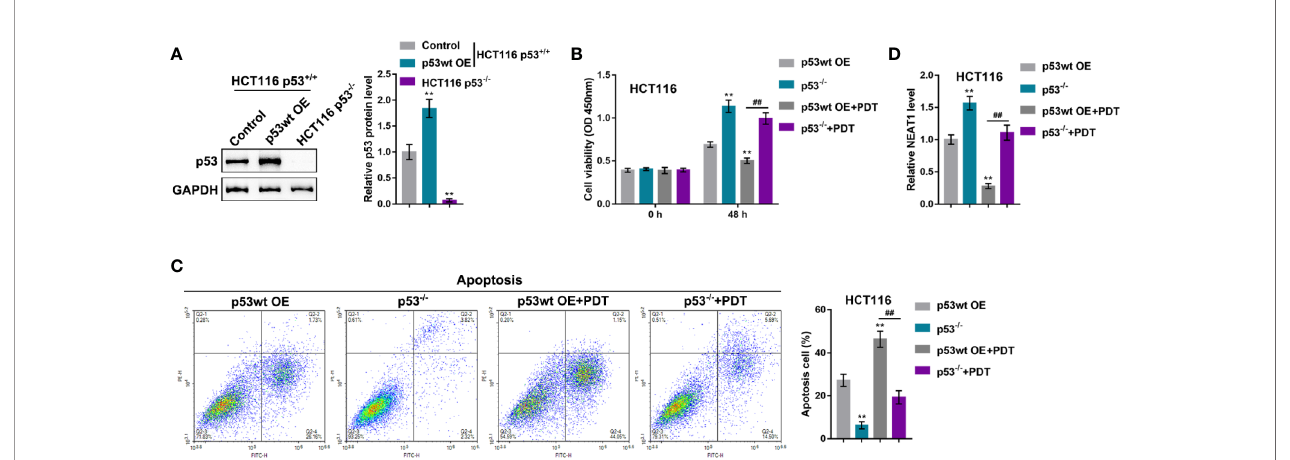
FIGURE 6 | p53 deletion enhances the resistance of CRC cells to PDT. (A) p53 overexpression was achieved in HCT116 cells by the transfecting p53- overexpressing vector (p53 OE). The protein levels of p53 were determined in regular HCT116 cells, p53 OE-transfected HCT116 cells, and p53 − / − HCT116 cells by Immunoblotting. Next, p53 OE-transfected HCT116 or p53-deleted p53 − / − HCT116 cells were treated or non-treated with PDT and examined for cell viability by CCK-8 assay (B) , cell apoptosis by fl ow cytometry (C) , and the expression levels of NEAT1 by qRT-PCR (D) . ** P < 0.01, compared to p53wt OE group; ## P < 0.01, compared to p53wt OE+PDT group.